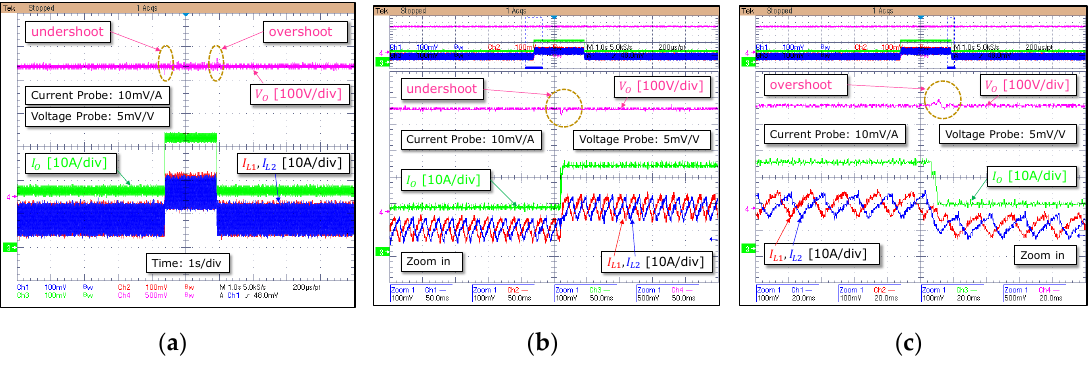
Figure 19. Experimental waveforms for ‘k-factor’ based controllers at V in = 250 V, V O = 385 V, R O = 25 Ω/12.5 Ω, ( a ) overview when 100% load change, ( b ) zoom-in waveforms for positive load change, ( c ) zoom-in waveforms for negative load change.